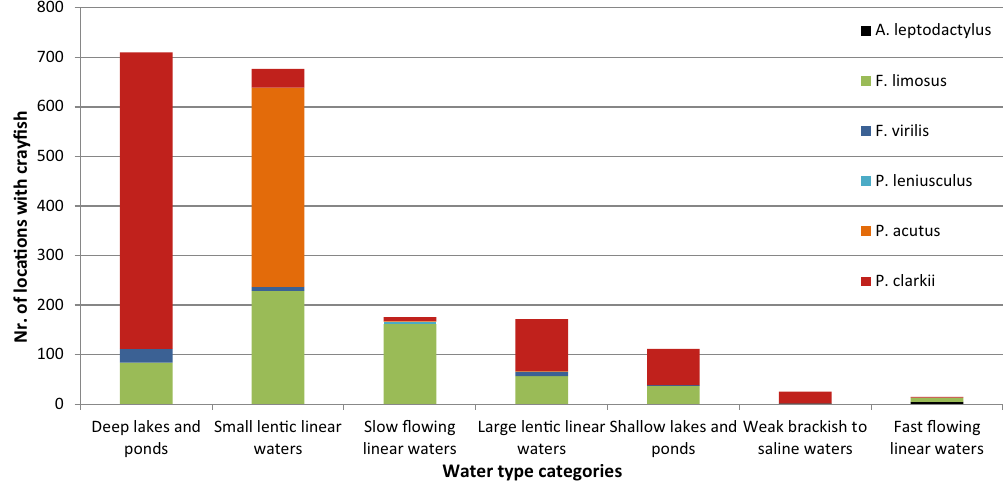
Figure 3. Number of sites per water type for each of the six crayfish species (data from 2007 to 2015).